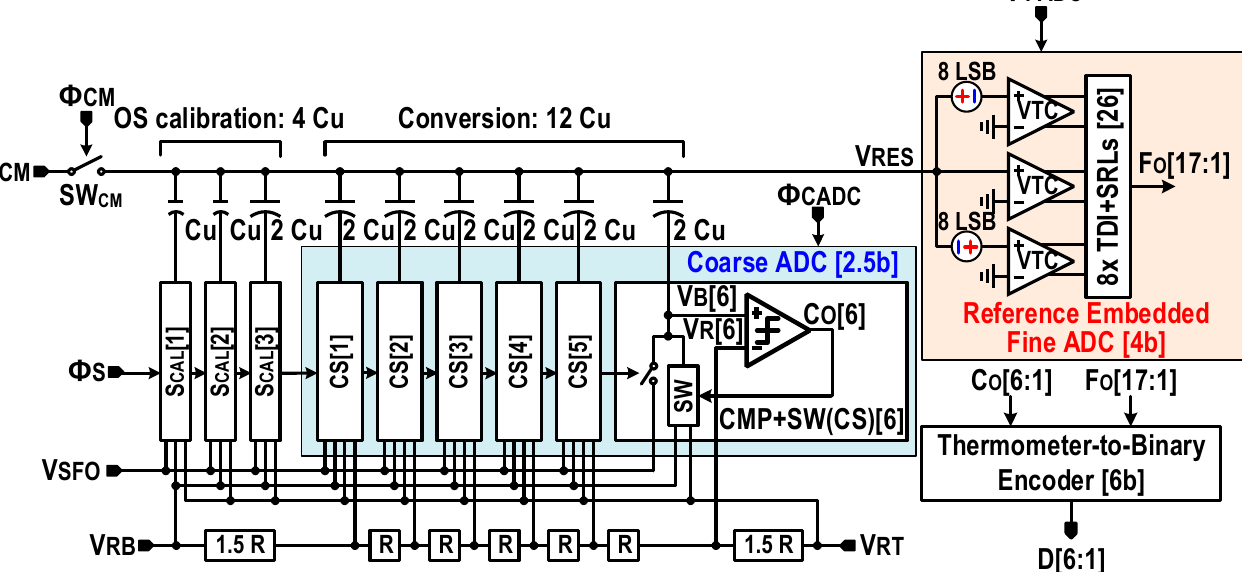
Figure 3. Block diagram of the 6-bit 1.25 GS/s two-step flash ADC.